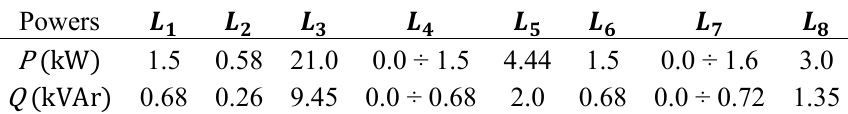
Table 5. Active and reactive powers absorbed by the